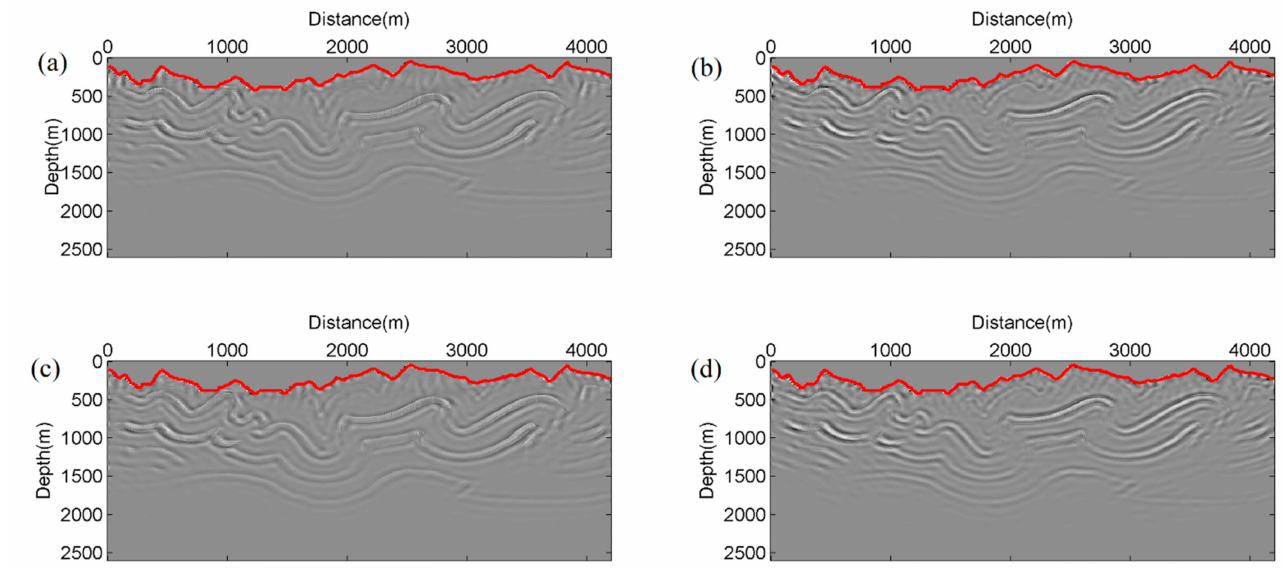
Figure 15. Migration images for modified Canadian Foothills elastic model with surface topography. The left panels are the PP-wave images, and the right panels are the PS-wave images. Incorrectly filled near-surface elastic parameters were used. Panels ( a , b ) are the migration images using low incorrectly filled near-surface elastic parameters, and panels ( c , d ) are the migration images using high incorrectly filled near-surface elastic parameters. The red line is the surface